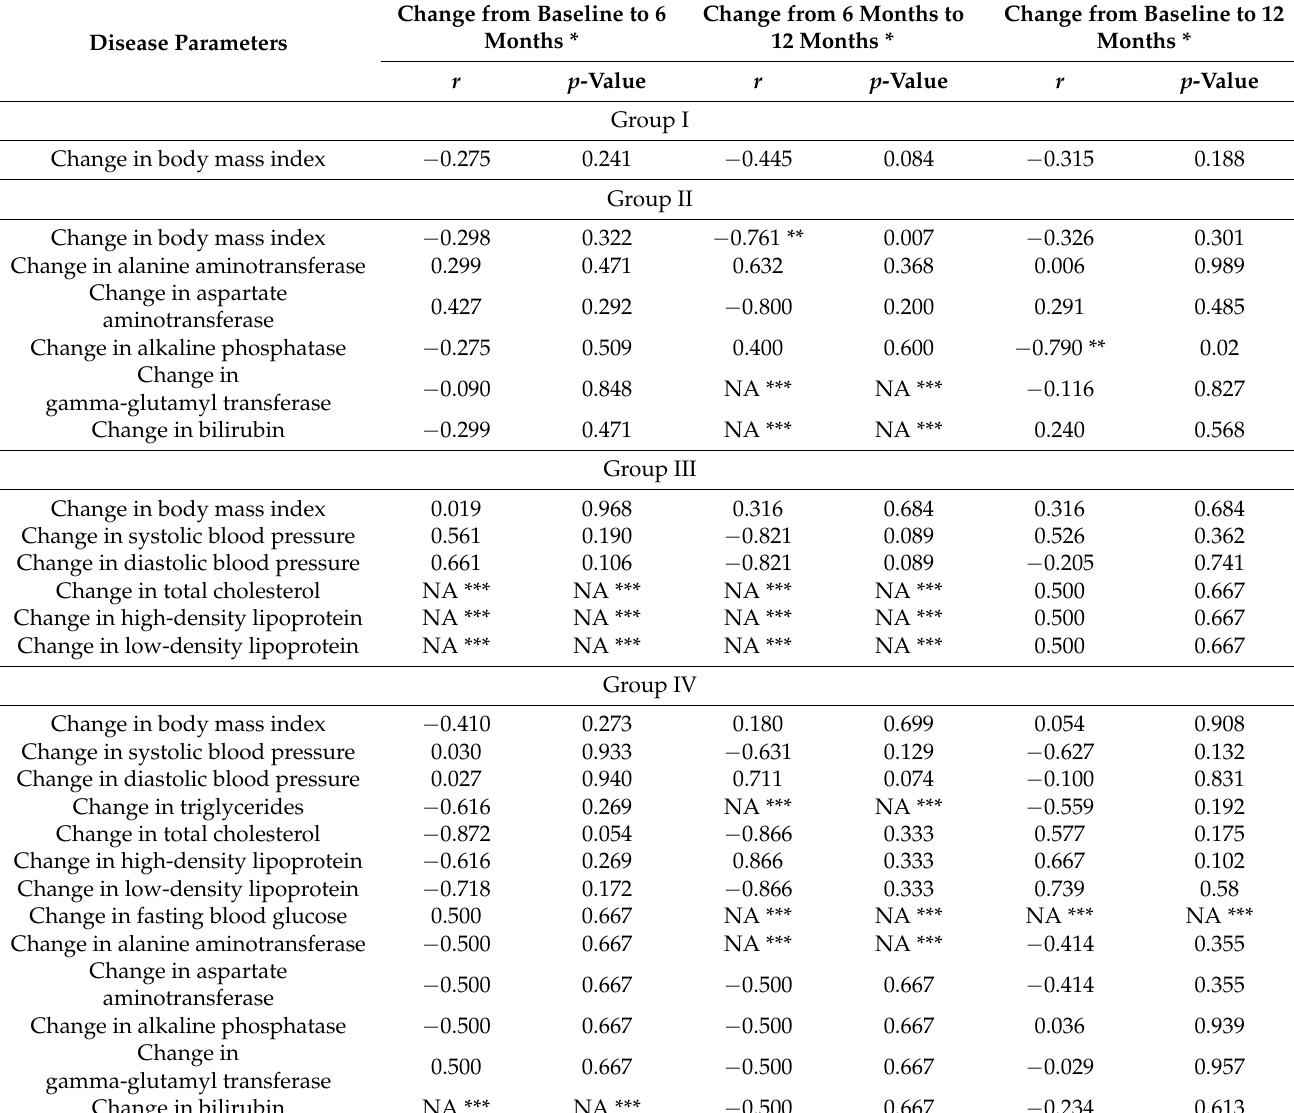
Table 7. Correlation of audit scores with disease progression among the four